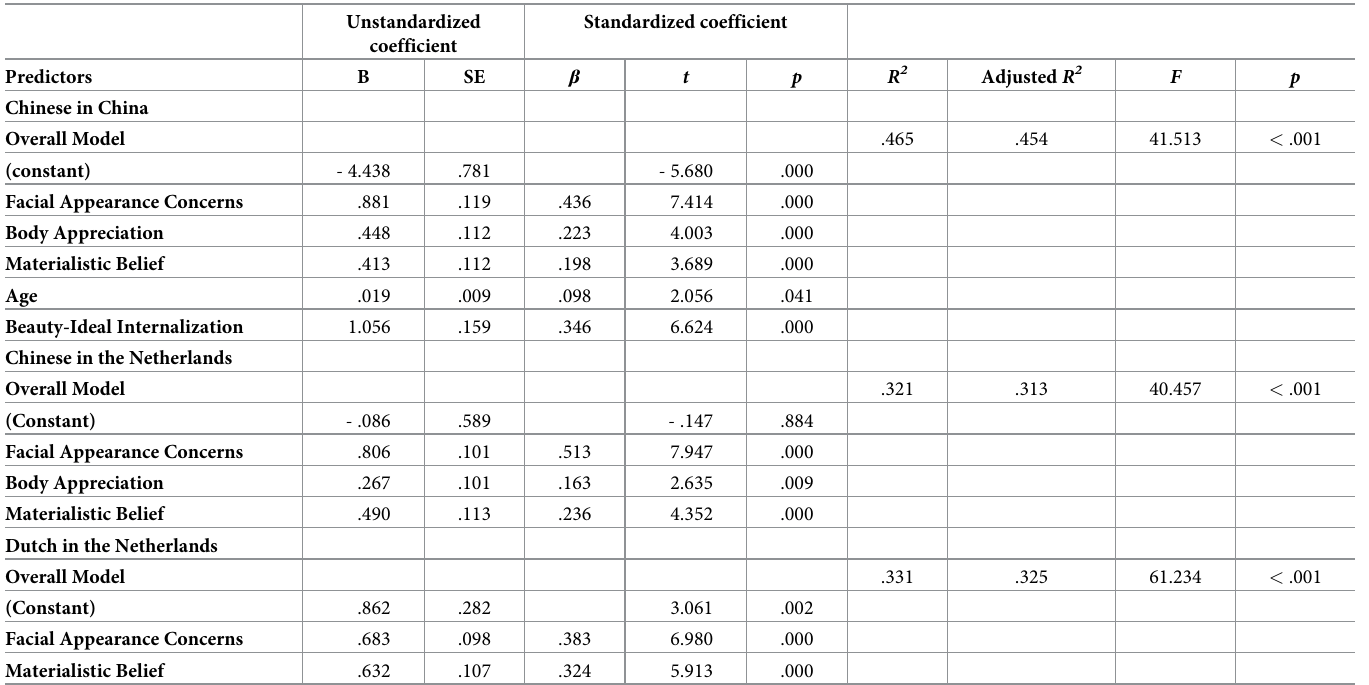
Table 5. Multiple regression models for all three cultural groups.